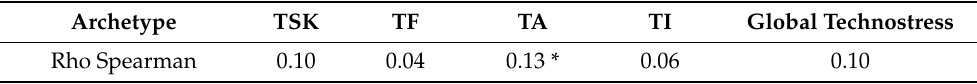
Table 10. Spearman correlations between archetypes and technostress. Archetype